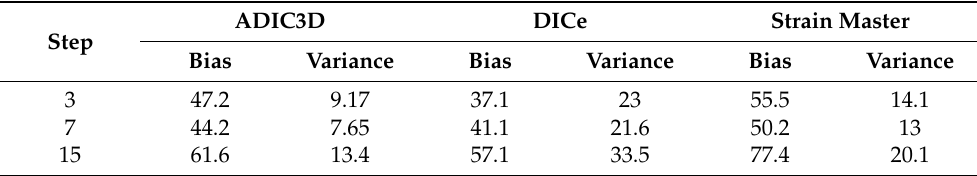
Table 15. Displacement error metrics for Sample 1 reported at × 10 − 3 mm.